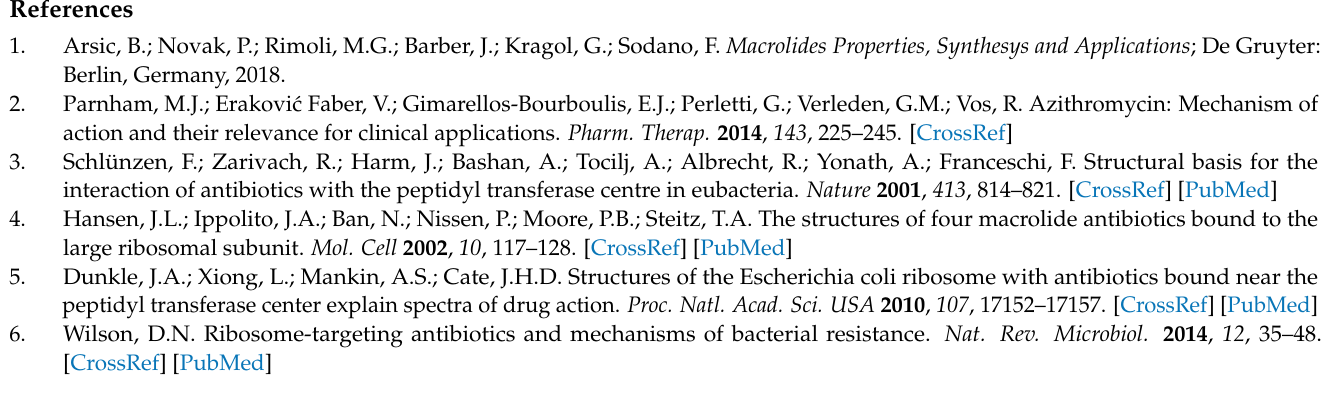
Table S3. Monitored distances around C-2 (cid:48) atom during the 500 ns of molecular dynamics simulations for different diastereomeric